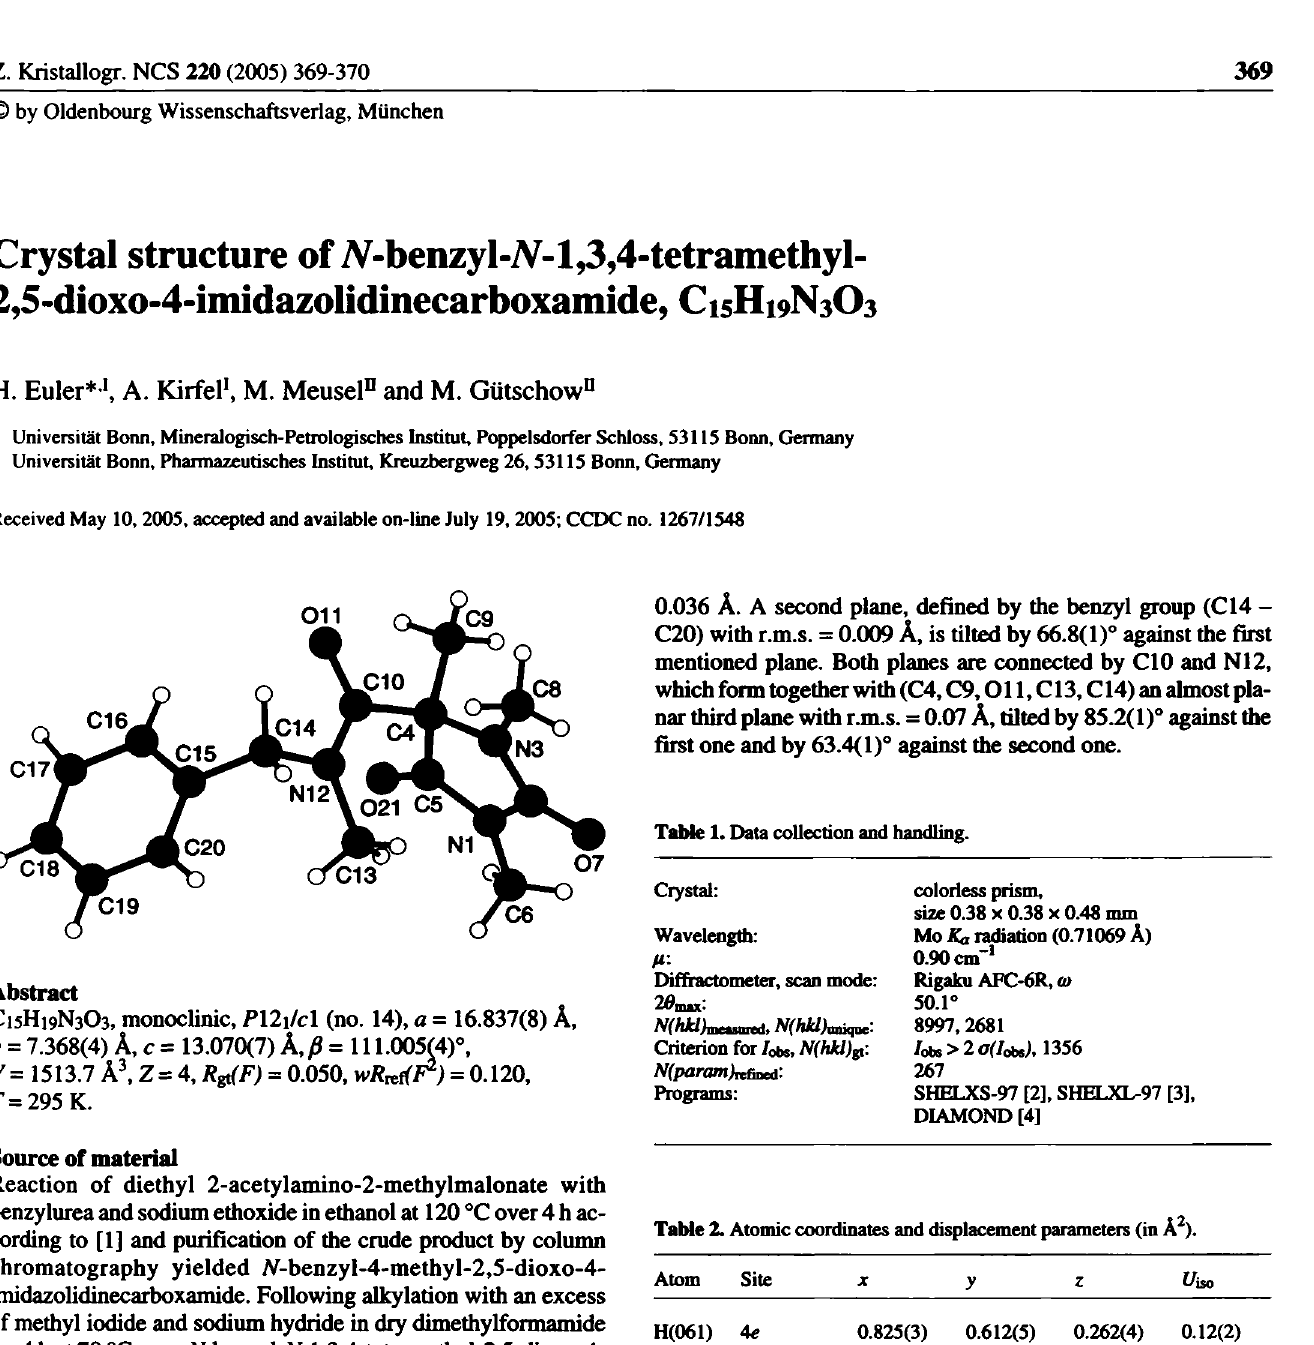
Table 2. Atomic coordinates and displacement parameters (in A 2